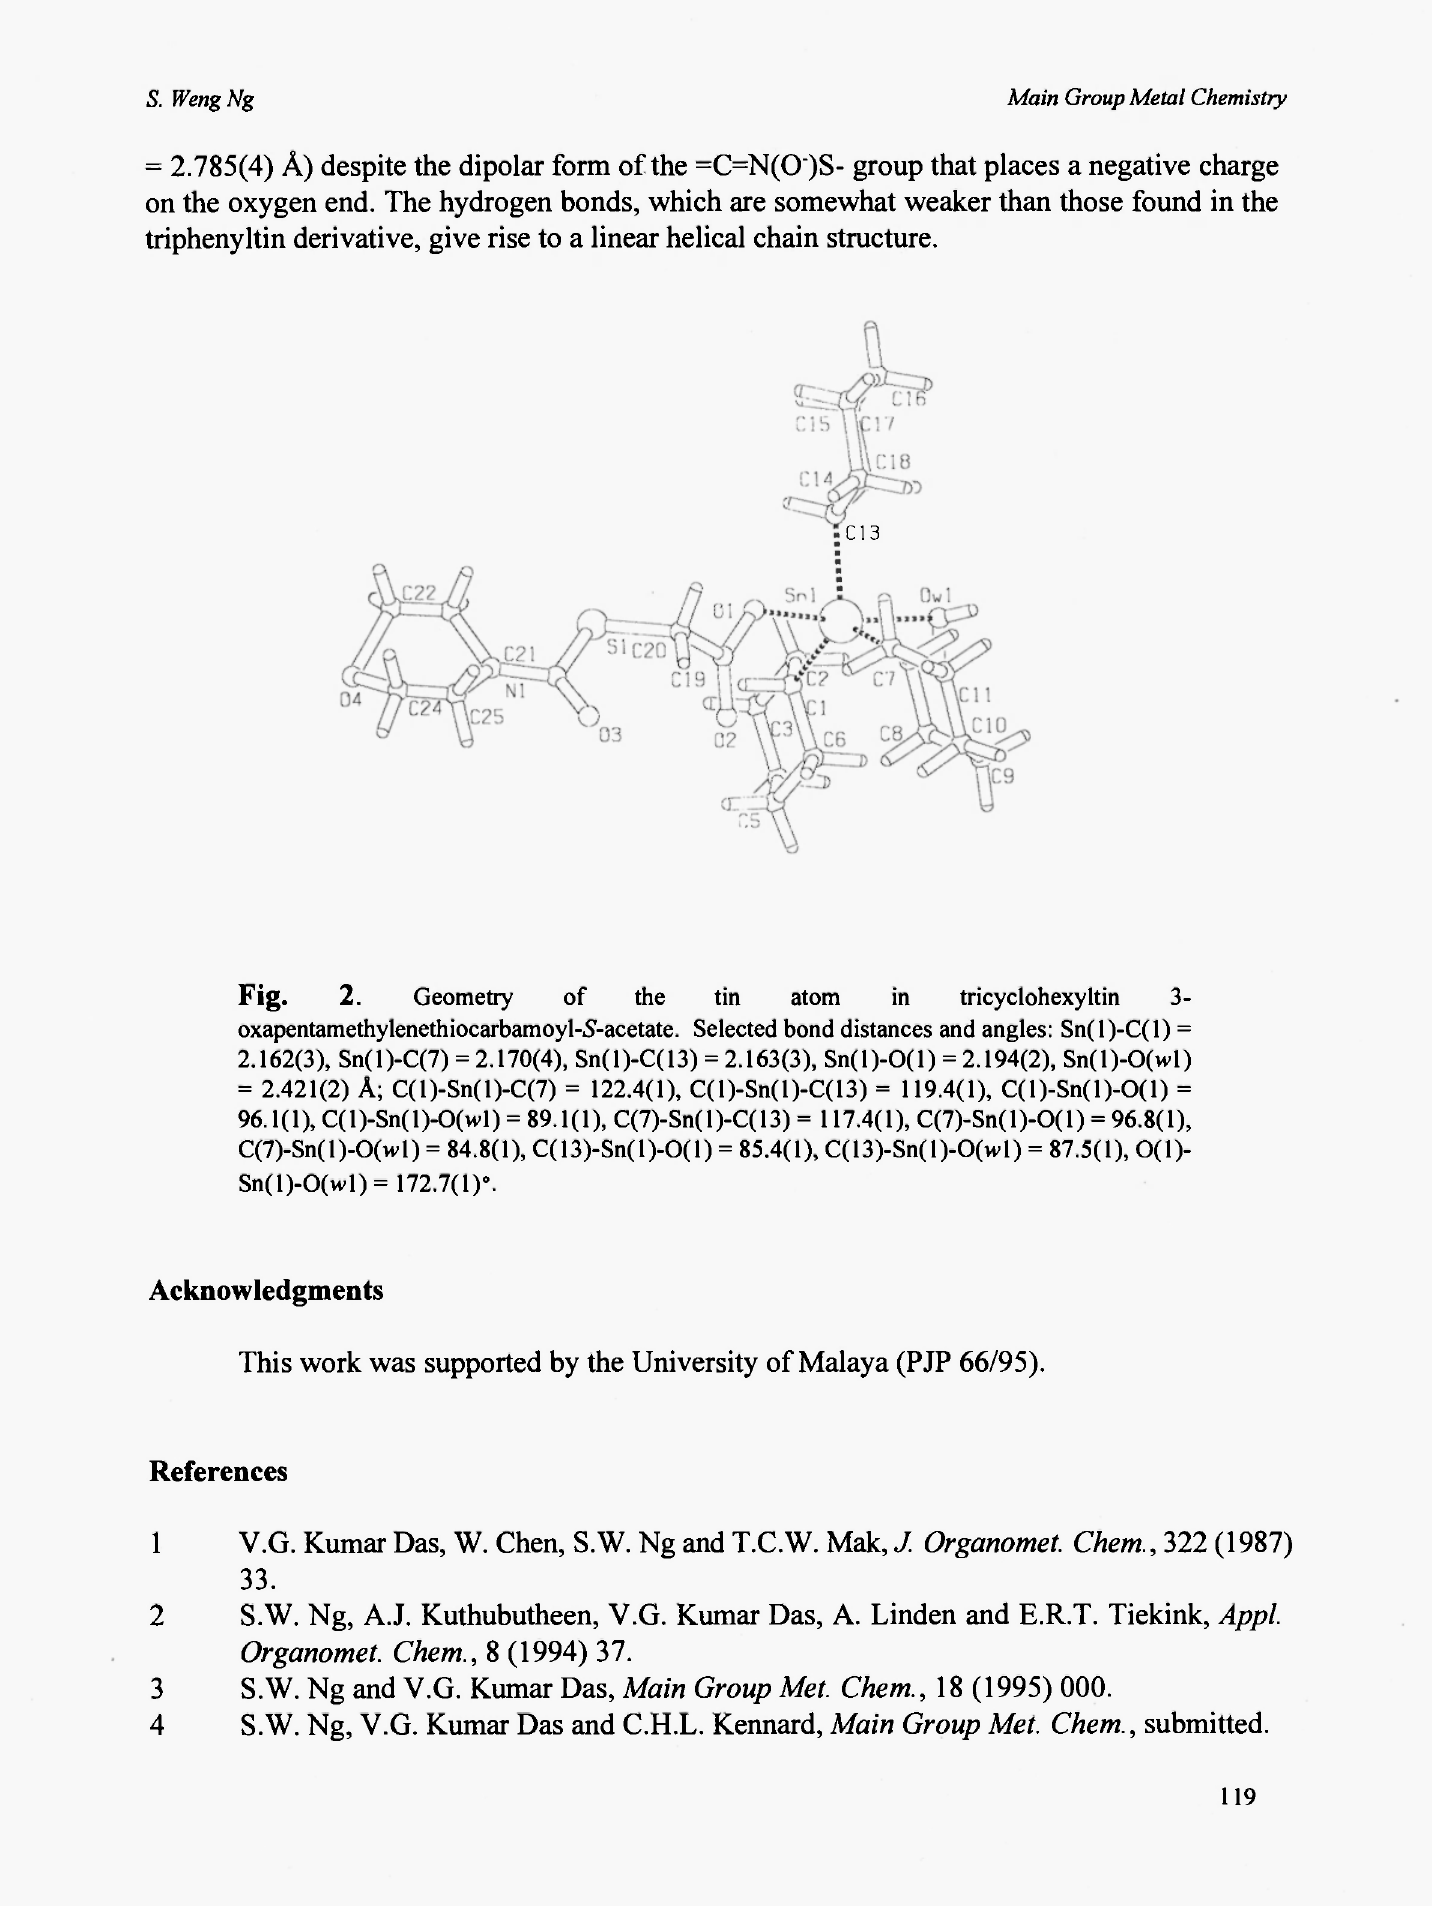
Fig. 2. Geometry of the tin atom in tricyclohexyltin 3- oxapentamethylenethiocarbamoyl-S-acetate. Selected bond distances and angles: Sn(l)-C(l) = 2.162(3), Sn(l)-C(7) = 2.170(4), Sn( 1)-C(13) = 2.163(3), Sn(l)-0(1) = 2.194(2),